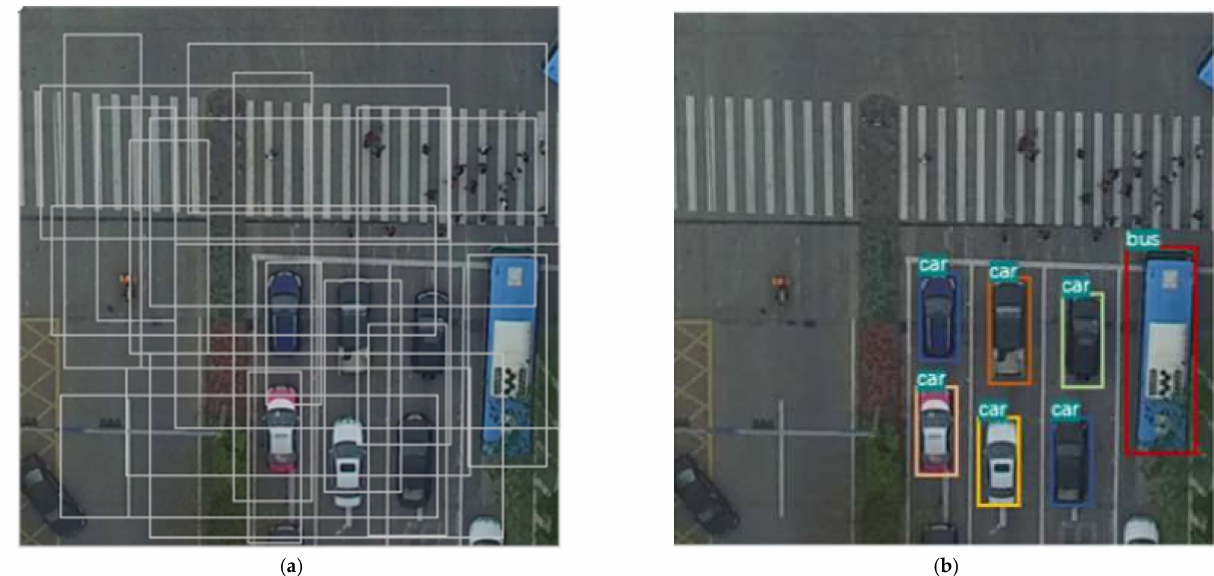
Figure 2. Schematic diagram of the vehicle prediction frame at different stages in the Sparse R-CNN. ( a ) Learnable suggestion box. ( b )